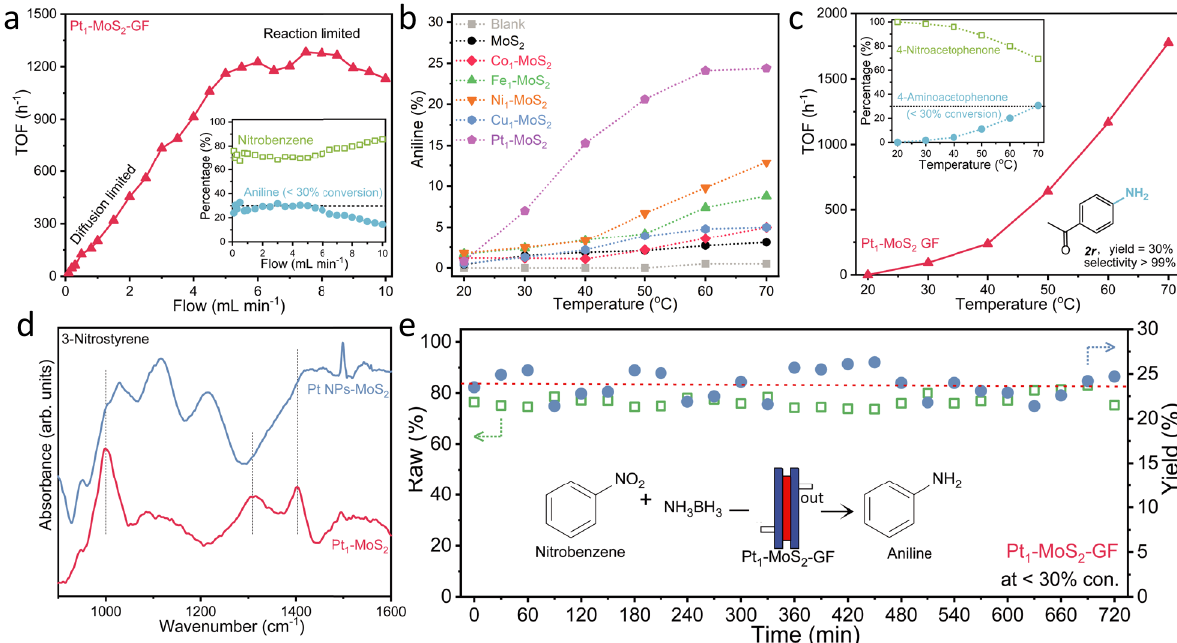
Fig. 4 Selective nitroarene reduction in the fl ow setup. a Plot of TOF versus fl ow rate, showing the mass fl ow-limited regime and reaction-limited regime in the fl ow cell performance. Inset shows the percentage of reactant and product at various fl ow rates; b Catalyst screening of various SACs and controls in the reaction-limited, low-conversion regime; c Veri fi cation on the chemoselectivity of Pt 1 -MoS 2 for the reduction of 4-nitroacetophenone. Inset shows the percentage of reactant and product at various temperatures, and the chemical structure of 4-aminoacetophenone (desired product); d In-situ DRIFTS spectra of Pt 1 -MoS 2 and Pt nanoparticles on MoS 2 after the hydrogenation of 3-nitrostyrene at 70°C; e A 12h on-stream demonstration of the Pt 1 -MoS 2 -GF catalyst in the low-conversion regime.